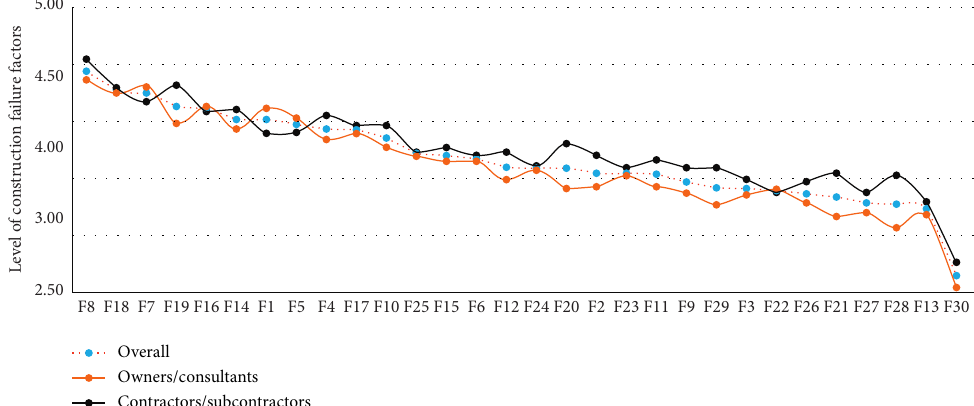
Figure 2: Cross-comparison of failure factors among